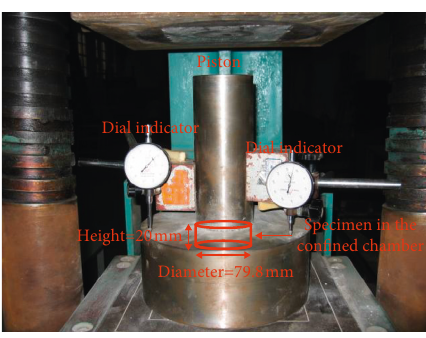
Figure 1: Initial grading curves.